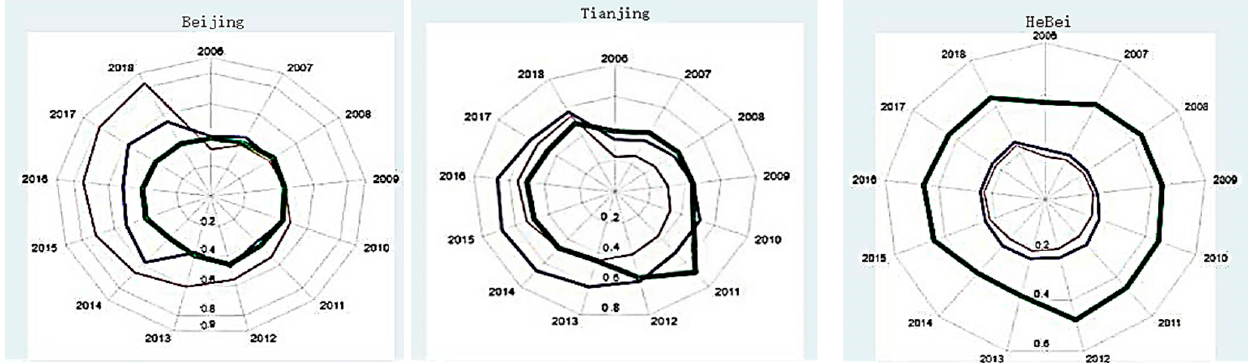
Figure 2. Complex development index of subsystems of economy–ecology–high-haze pollution industries, such as the thermal power industry, in the Beijing–Tianjin–Hebei region.